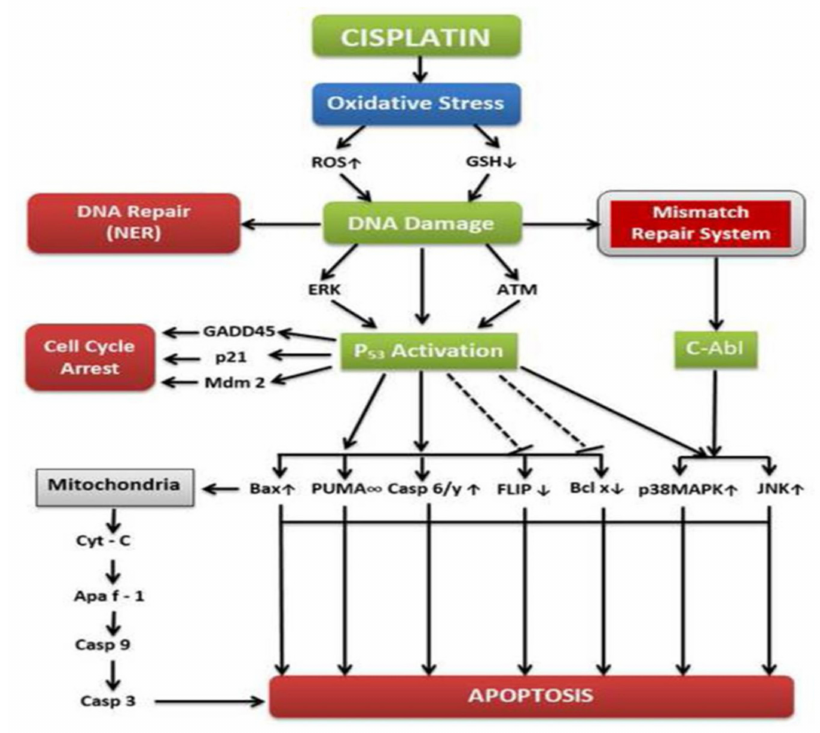
Figure 2. Overview of the molecular mechanisms of cisplatin in cancer treatment